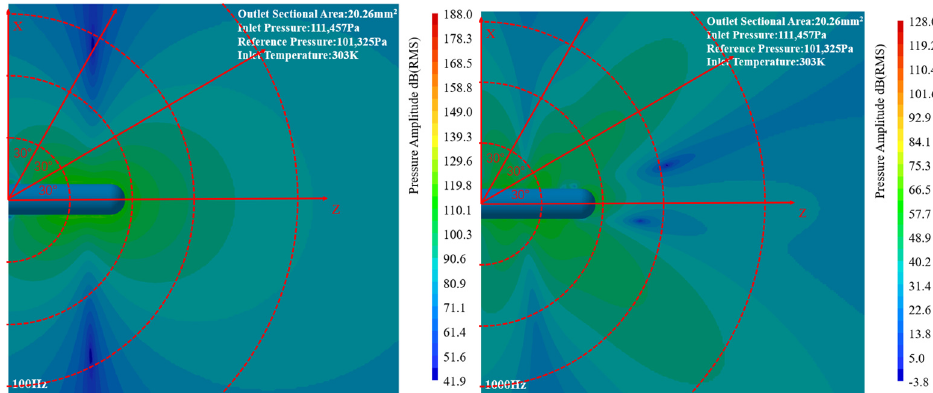
Figure 25. Nephograms of the 100 Hz and 1000 Hz far-field sound pressure levels of equal-diameter